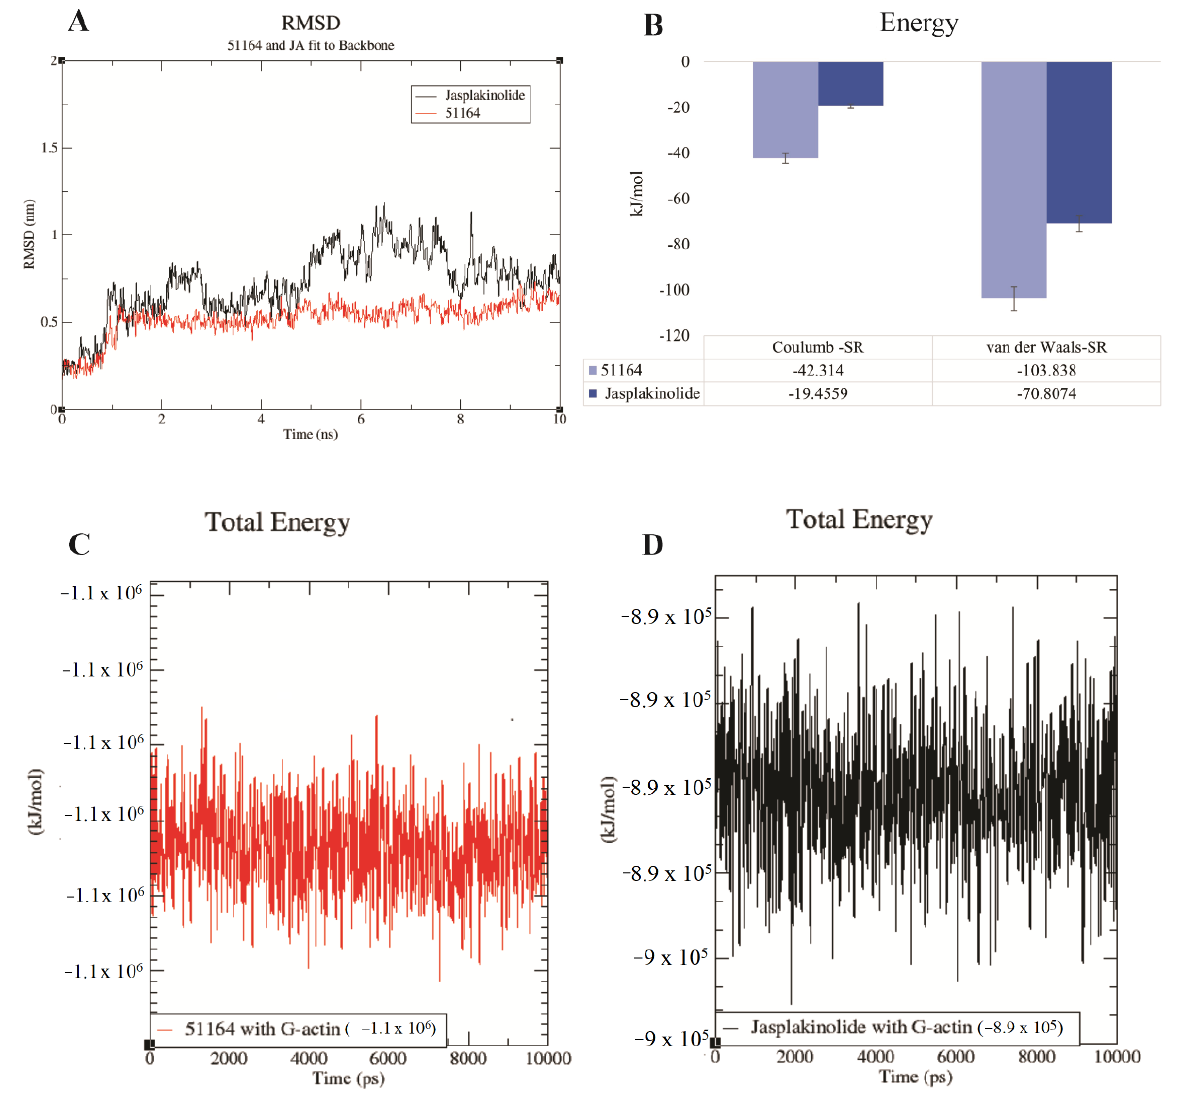
Figure 7. Calculated spatial–energy values for the complexes of 51164–G-actin and jasplakinolide–G-actin. ( A ) The RMSD value for the study complexes. ( B ) Calculated values of Coulomb and van der Waals forces for two complexes. Total energy values of 51164–G-actin ( C ) and jasplakinolide—G-actin ( D ).